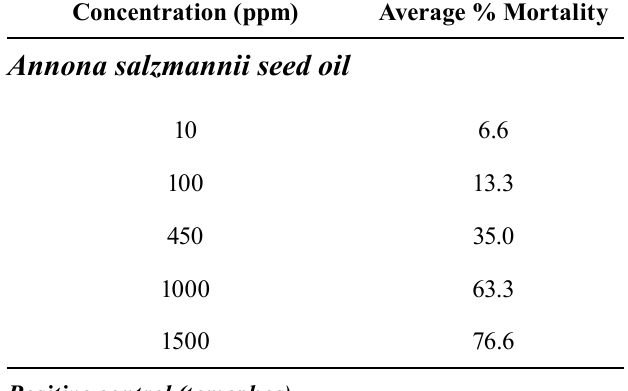
Concentration (ppm) Average %